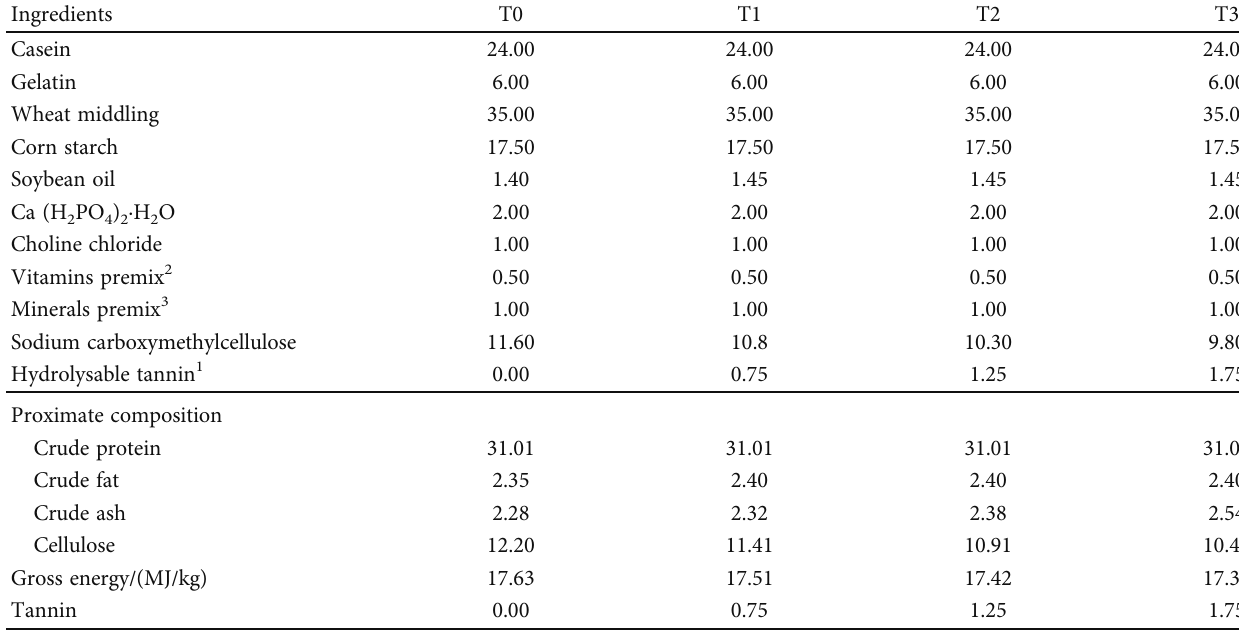
Table 1: Composition and nutrient levels of semipuri fi ed diets (air dry basis)